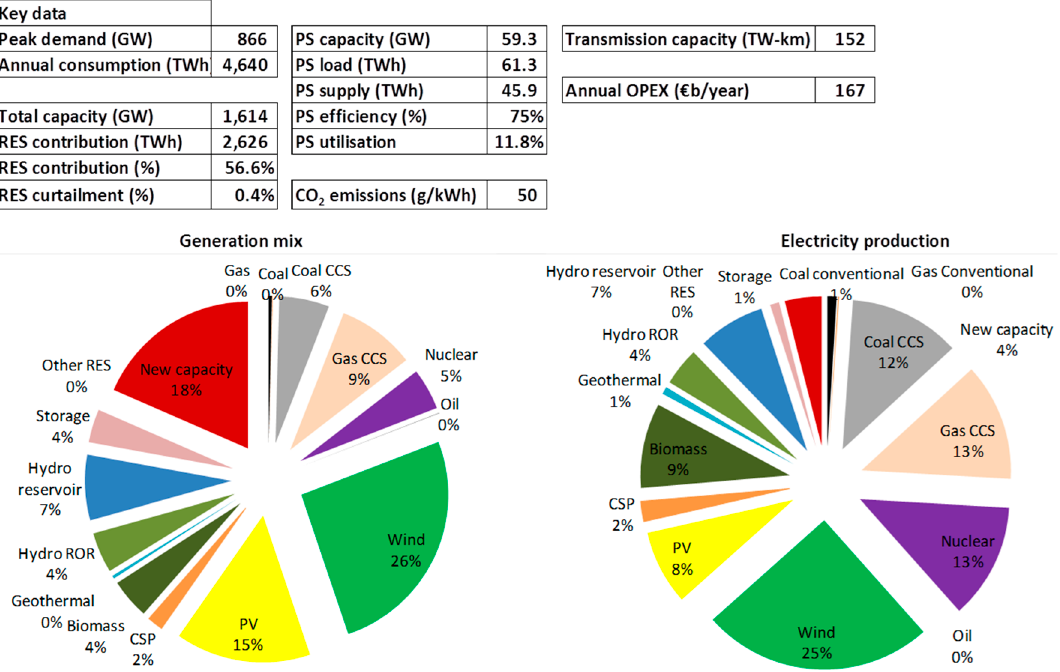
Figure A3. Low RES scenario for 2040.